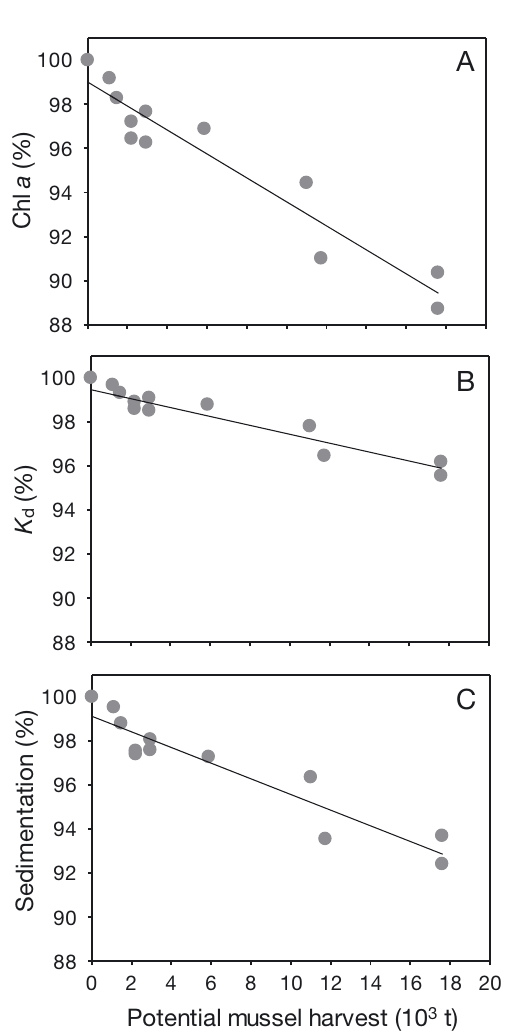
Fig. 7. Spatially integrated basin-scale changes in (A) sum- Fig. 8. First-year spatially integrated basin-scale effects on mer chl a concentration, (B) light attenuation ( K d ) and (C) (A) summer chl a concentration, (B) light attenuation ( K d ) sedimentation as a function of the total mussel biomass and (C) sedimentation as a result of nitrogen reduction available for harvest in May 2011. Environmental effects of either by harvest of mussel mitigation cultures or by nutrient mussel mitigation farms have been integrated over the load reductions from land. Nitrogen reduction is calculated entire area of Skive Fjord (see Fig. 1C) and are shown as after 1 yr (June−May) of either load reductions or mitigation the relative change (in %) compared to a situation without mussel growth and subsequent harvest. Basin-scale effects mussel farms of nutrient load reduction and mitigation mussel farms have been integrated over the entire area of Skive Fjord (see Fig. 1C) either including the area occupied by mussel farms or compared to terrestrial measures (10 × 10 −3 % t −1 N re- where effects within the farms have been excluded. All re- moved). If the area occupied by the mussel farms was sults are shown as relative change between the scenario and omitted from the spatial integration, basin-scale ef- a situation with no mussel mitigation farms and no reduction in nutrient reductions were slightly reduced, fects of chl a and K d whereas sedimentation reductions increased (Fig. 8).